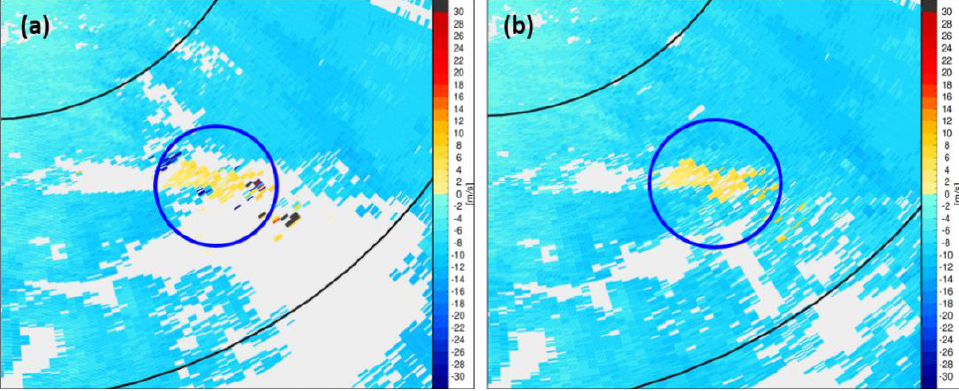
Figure 11. Examples of ( a ) before and ( b ) after outlier correction and retrieval of radial velocity using VAD fits at an elevation angle of −0.2° for KWK at 0400 LST on 24 July 2020.